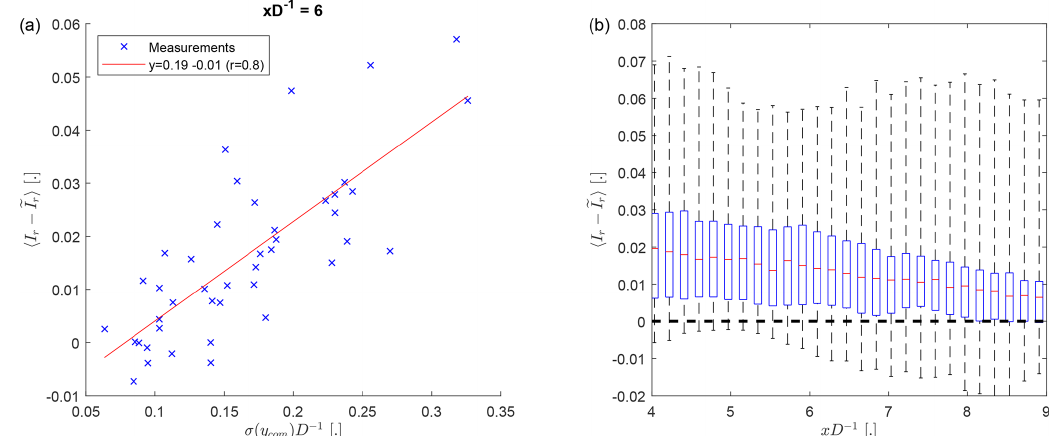
Figure 13. Laterally averaged difference of the radial turbulence intensity at xD − 1 = 6 between the nacelle frame of reference ( I r ) and the meandering frame of reference ( (cid:101) I r ) as a function of the wake meandering strength (a) . The distribution of observed turbulence intensity differences as a function of xD − 1 is shown in panel (b) , with the whiskers showing the range of the data, the top and bottom of the blue box indicating the 25th and 75th percentiles, and the red centre marker showing the median. The angle brackets indicate the lateral averaging.